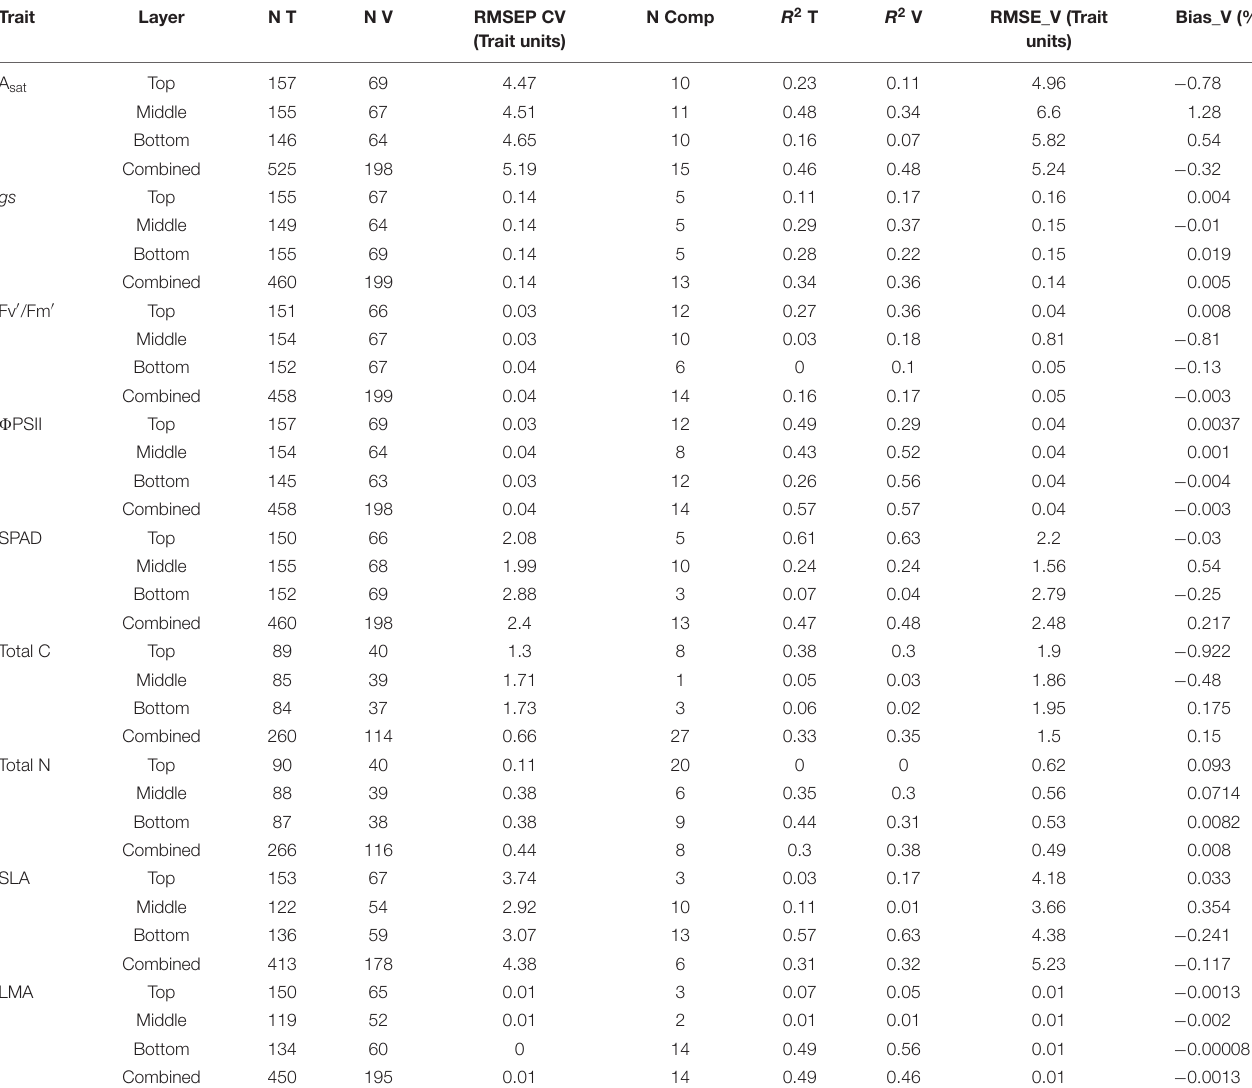
TABLE 1 | Statistical parameters used to build the partial least squares regression (PLSR)